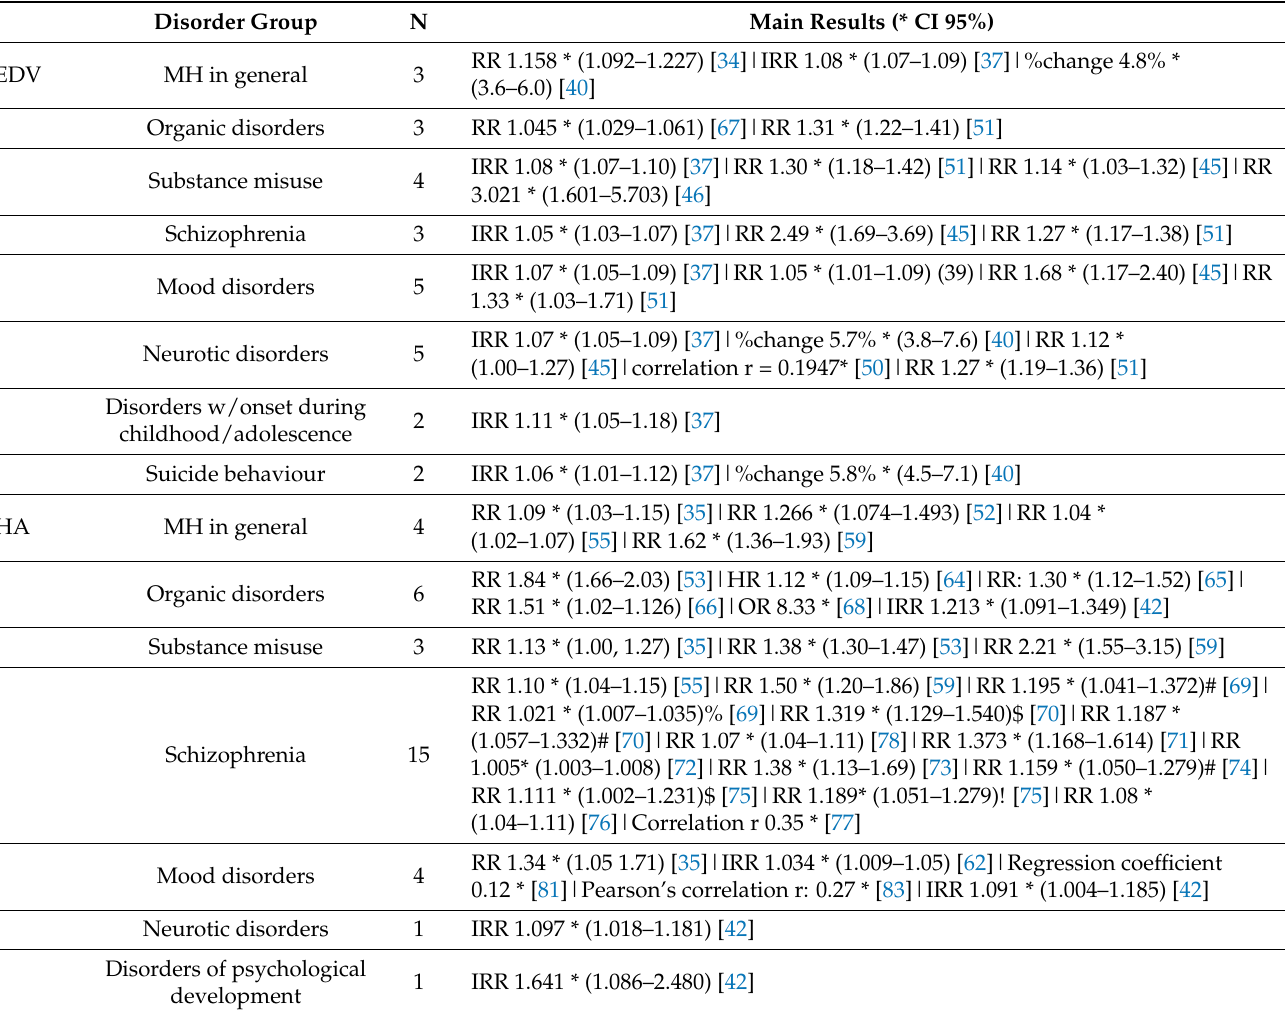
Table 4. Meteorological